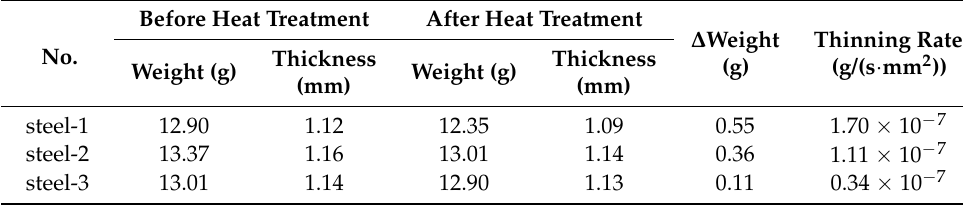
Figure 3. Morphology of urea corrosion region and depth of oxide layer and intergranular corrosion zone ( a – c ) and total penetration depth ( d ): ( a ) steel-1, ( b ) steel-2, ( c ) steel-3, and ( d ) total penetration depth of the three steels. Table 2. Average thinning rate of experimental steels before and after heat treatment.